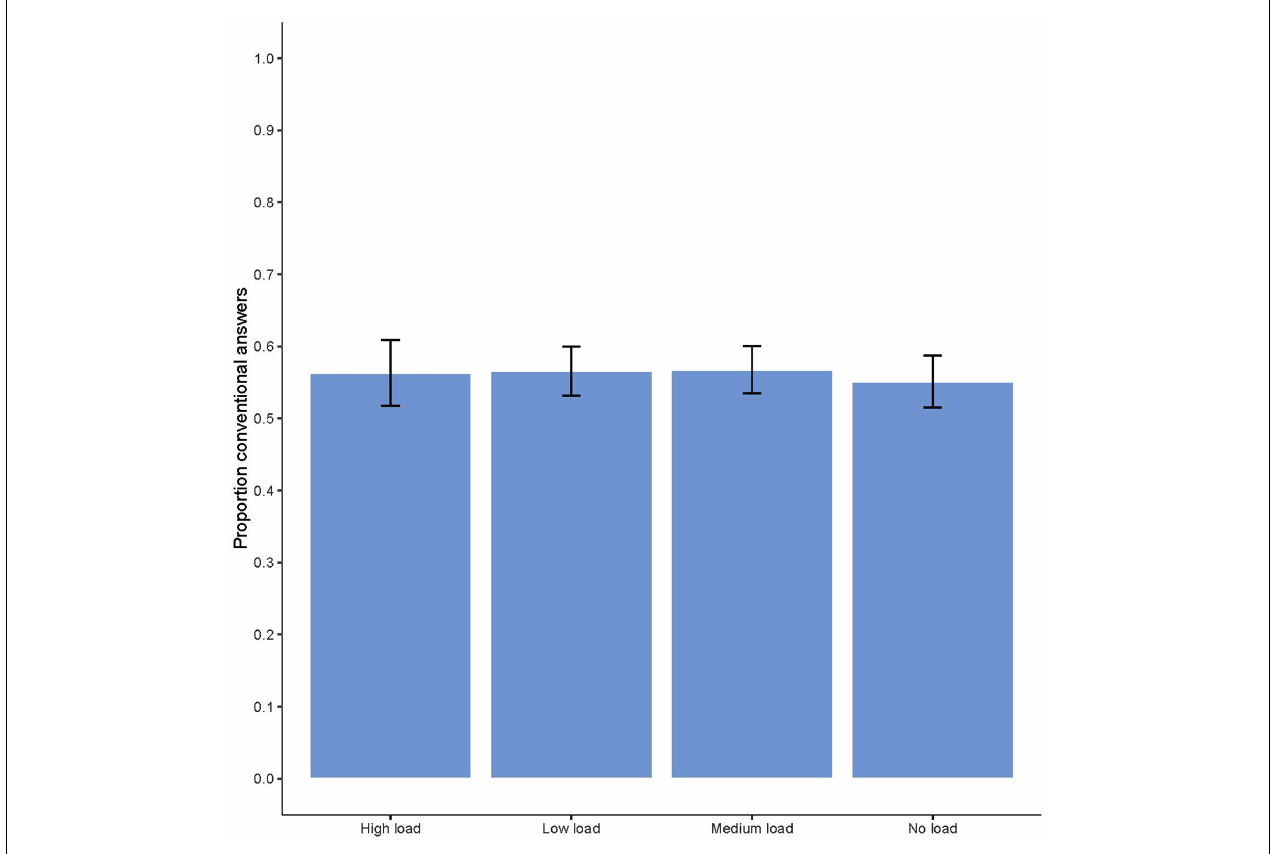
FIGURE 1 | Proportion of conventional answers for each of the four